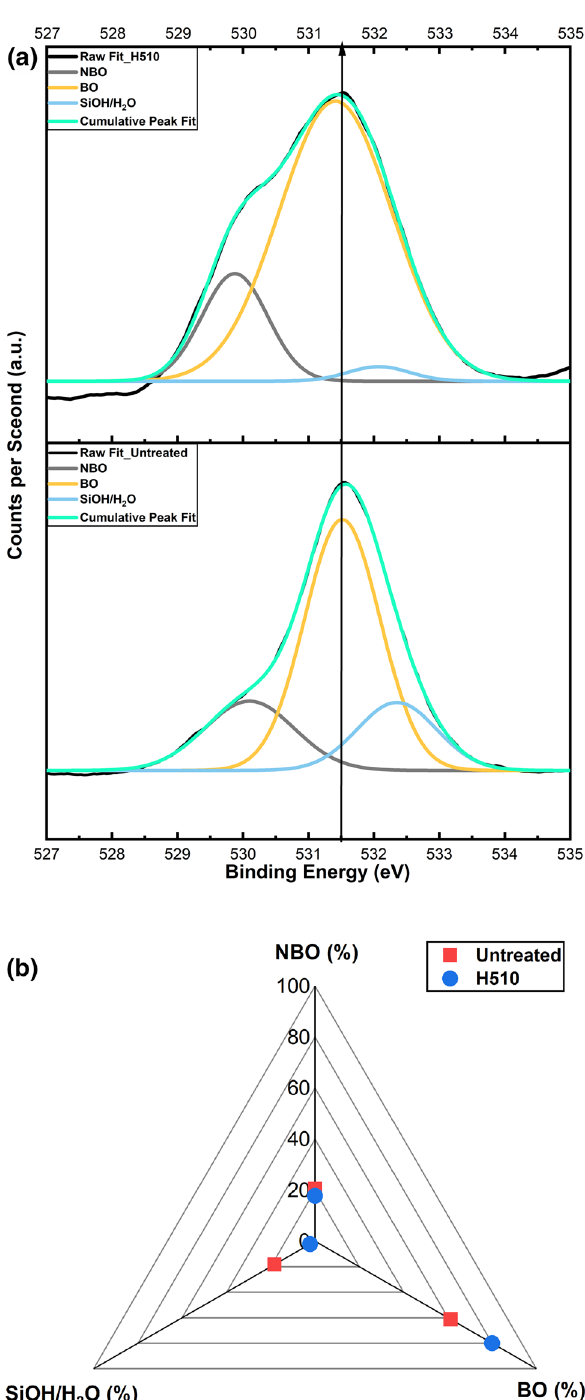
Figure 3. XPS results of untreated and heat-treated SLS surfaces (0–5 nm): (a) 100% Gaussian deconvolution of the O1s orbital and (b) comparative illustration of the distribution of bridging oxygen (BO), non-bridging oxygen (NBO) and SiOH/H 2 O species on both